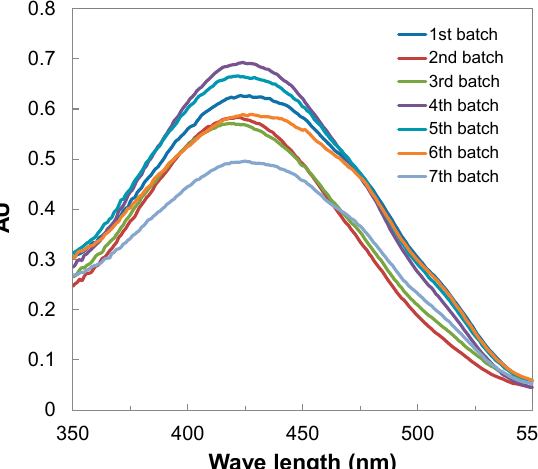
Figure 4. Extracellular pigment production and glucose consumption in repeated-batch extractive fermentation with immobilized cells. ( A ): First batch; ( B ): second batch; ( C ): third batch; ( D ): fourth batch; ( E ): fifth batch; ( F ): visible spectrum shift of extracellular pigments in the process of the first batch.